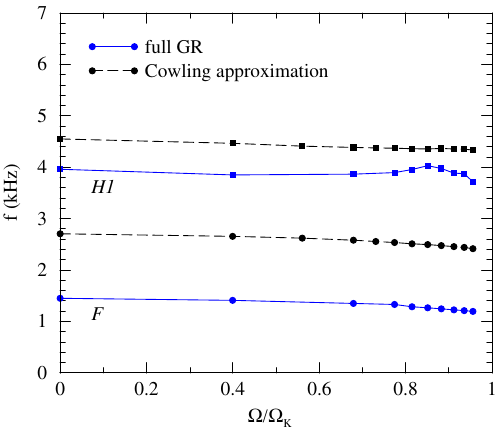
Fig. 28 The first fully relativistic, quasi-radial pulsation frequencies for a sequence of rapidly rotating N = 1 polytropes, up to the mass-shedding limit (with fixed central density along the sequence). The frequencies of the fundamental mode F (filled circles) and of the first overtone H 1 (filled squares) are obtained through coupled hydrodynamical and spacetime evolutions (blue solid lines). The corresponding frequencies obtained from computations in the relativistic Cowling approximation (fixed spacetime) (Font et al. 2001) are shown as black dashed lines. (Image reproduced with permission from Font et al. 2002, copyright by